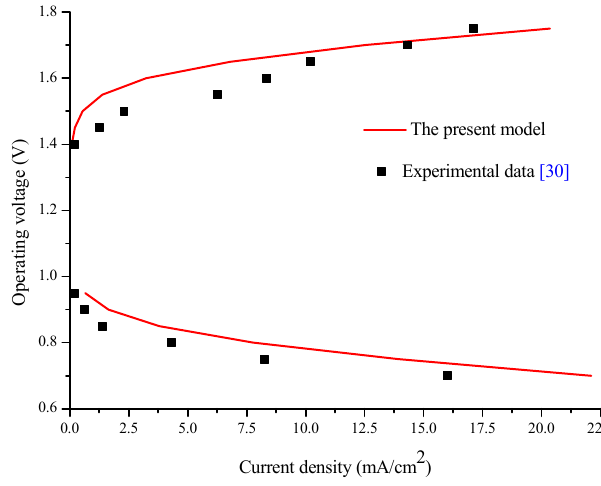
Figure 4. Comparison of the computed URFC performance with the experimental results.